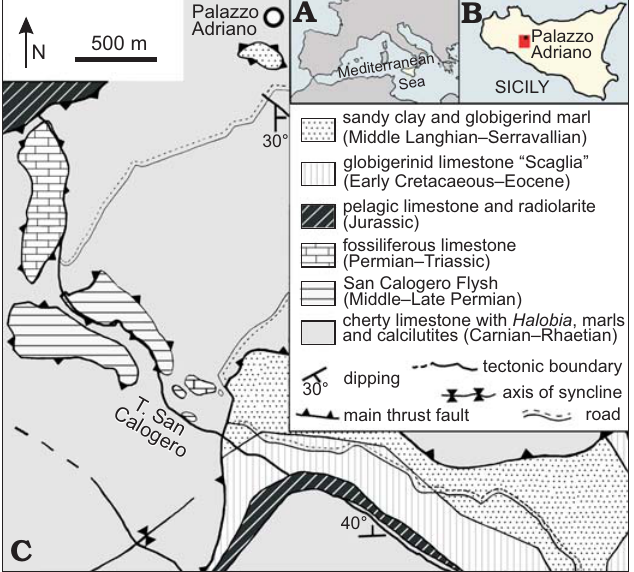
Fig. 1. A . Location of the study area in the Mediterranean and Sicily. B . Geo logical map of the Palazzo Adriano area (Sicani Mountains) show- ing the location of the fossiliferous limestone blocks. Holocene deposits not shown. Material was collected in blocks cropping out in areas indicated as “fossiliferous